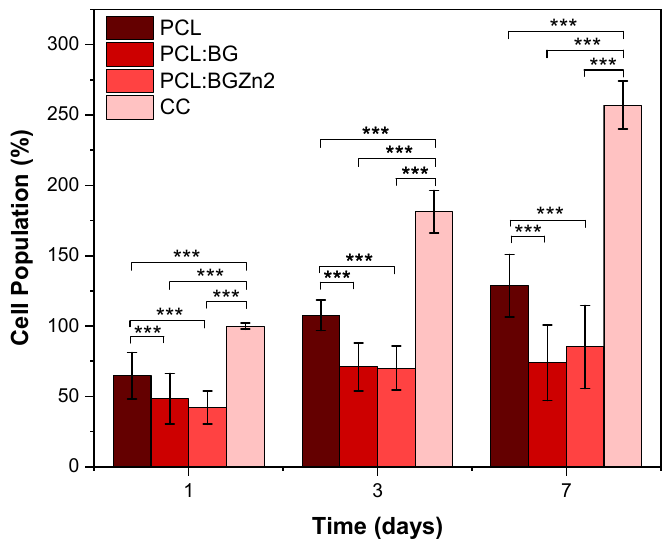
Figure 10. Saos-2 adhesion and proliferation rate for 1, 3 and 7 days in PCL, PCL:BG and PCL:BGZn2 membranes (*** p <